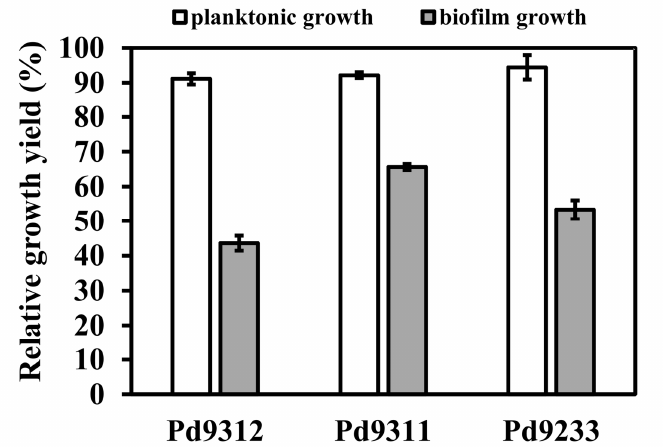
Figure 2. Planktonic bacterial growth (left bars) and biofilm formation (right bars) in polystyrene Petri dishes after 72 h. Data are normalized to wild-type values. Bar heights show mean values of five replicates, error bars show standard deviations. Means represented by left bars do not statistically differ (ANOVA, p = 0.12), while right bar values differ significantly from each other ( t -test, p < 0.01).